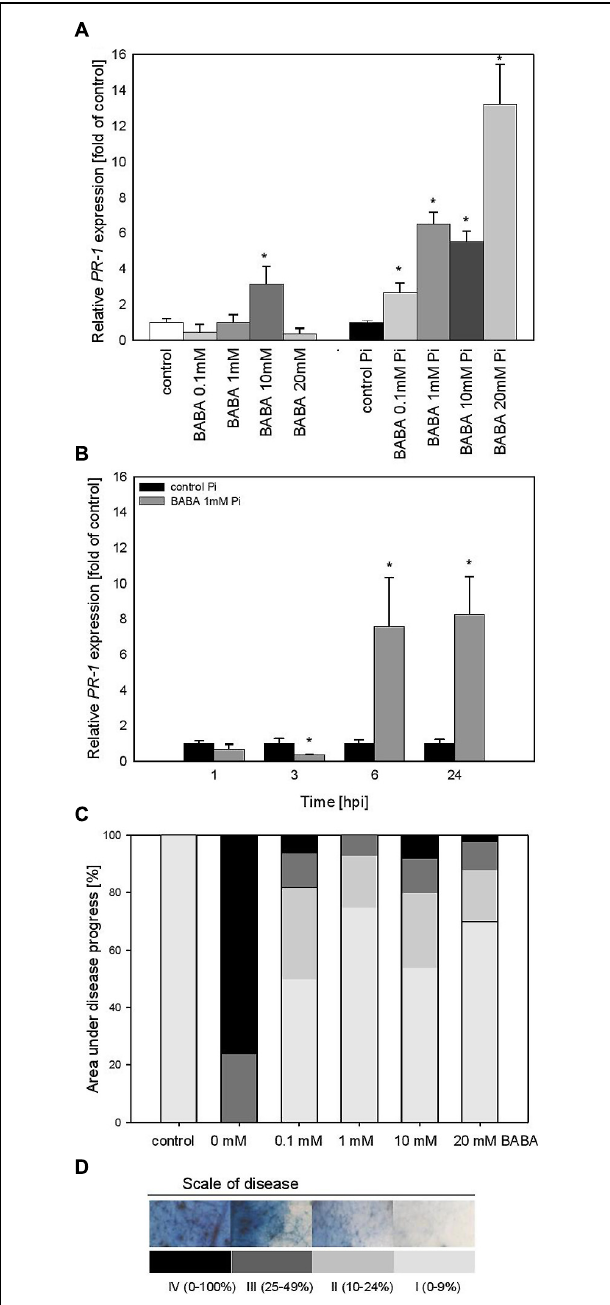
FIGURE 2 | PR-1 gene transcript accumulation and BABA dose-dependent protection against Phytophthora infestans in potato leaves (B 0 ). (A) PR-1 gene transcript accumulation at 3 days after induction with BABA (left bars) and 24 h after inoculation of previously induced plants (right bars), (B) a time-dependent analysis of PR-1 gene expression in P. infestans -inoculated plants previously treated with 1 mM dose of BABA (in B 0 stage), (C) an index of disease development at 7 dpi in directly BABA-treated parents B 0 , (D) a scale corresponding to the area of leaves covered with late blight and to trypan blue staining of P. infestans mycelium. ∗ Significantly different from control leaves, P < 0.05. Values represent means of data ± SD of at least three independent experiments, each with at least three biological